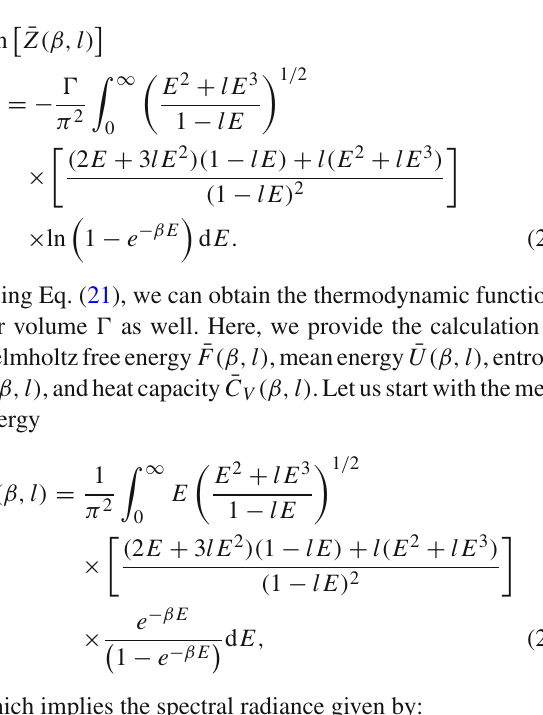
Fig. 8 The plots show how the spectral radiance ¯ χ(ν) changes as a function of frequency ν and l ( whose dimension is m · kg − 1 / 2 · s − 1 ) for three different cases. The top left (dotted) is configuration to the cosmic microwave background, i.e., β = 10 13 GeV; the top right (dot-dashed)